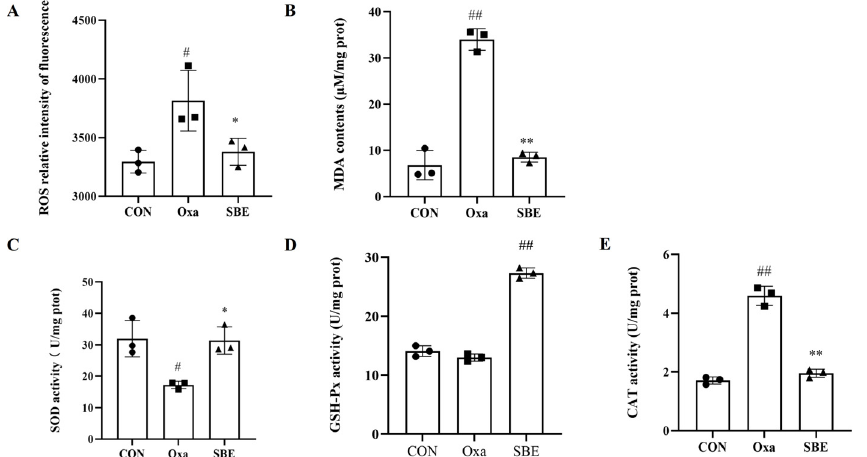
Figure 3. Effects of SBE on the oxidative stress biomarkers. Zebrafish intestines were collected, and the ROS relative intensity of fluorescence ( A ), the MDA contents ( B ), and the enzyme activities of SOD ( C ), GSH-Px ( D ), and CAT ( E ) are shown. Fold changes are expressed as means ± SD (n = 30 per group). Groups with different letters statistically differ (compared with the CON group, # p < 0.05, ## p < 0.01; compared with the Oxa group, * p < 0.05, ** p < 0.01).